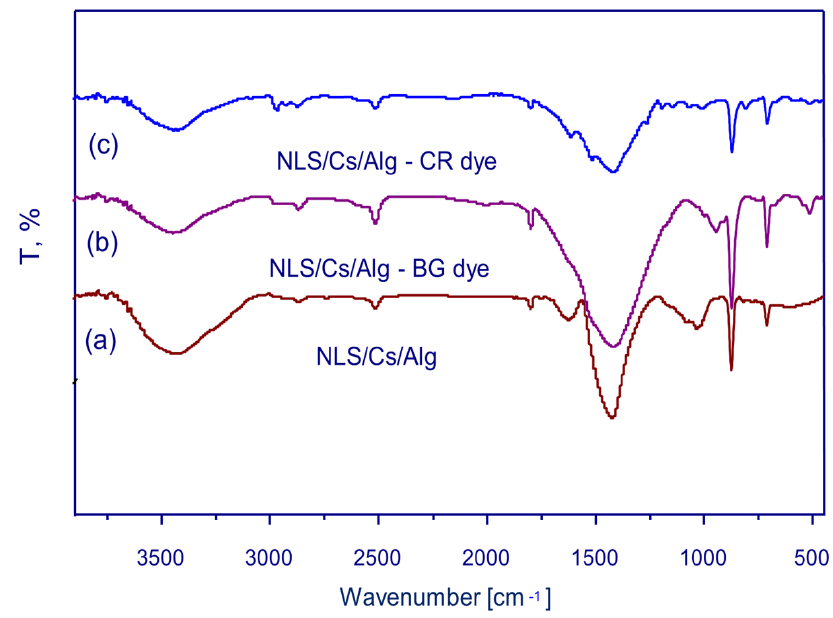
Figure 1. FTIR for ( a ) limestone–chitosan–alginate (NLS/Cs/Alg.), ( b ) NLS/Cs/Alg. brilliant green (BG) dye, and ( c ) NLS/Cs/Alg. Congo red (CR) dye.